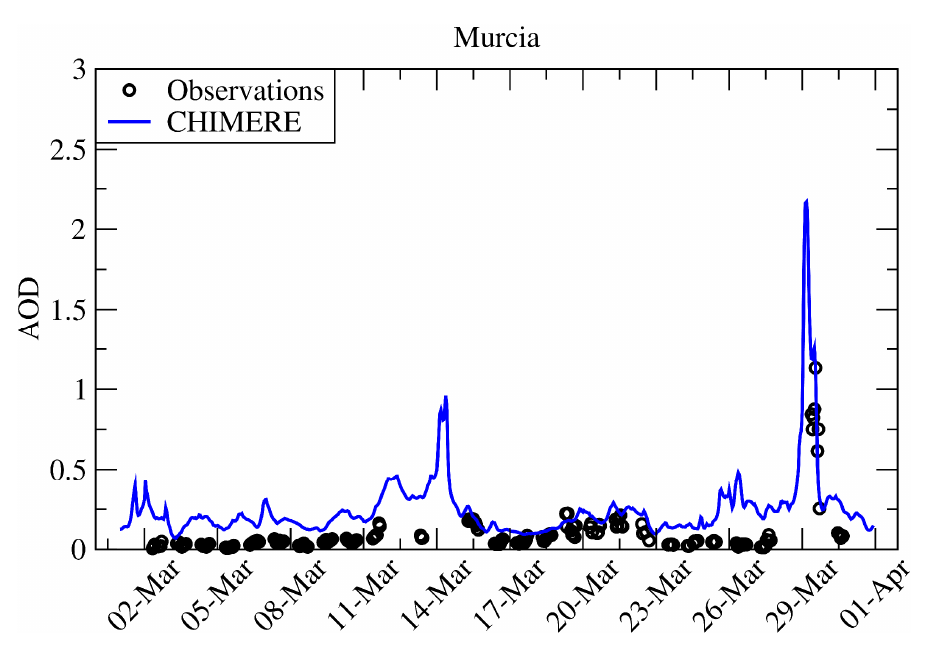
Figure 15. Time series of simulated (CHIMERE) and observed AERONET AOD 870 nm for March 2014 at Murcia (southeast of Spain).